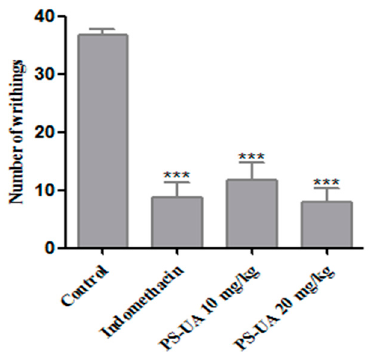
Figure 4. The antinociceptive effect of PS-UA (10 and 20 mg/kg; oral administration) and the reference drug indomethacin (20 mg/kg; intraperitoneal administration) in the acetic acid-induced writhing assay. The bars represent the mean numbers of writhing ± SD. (***) indicates a significant difference ( p < 0.001) in the number of contortions versus the control.